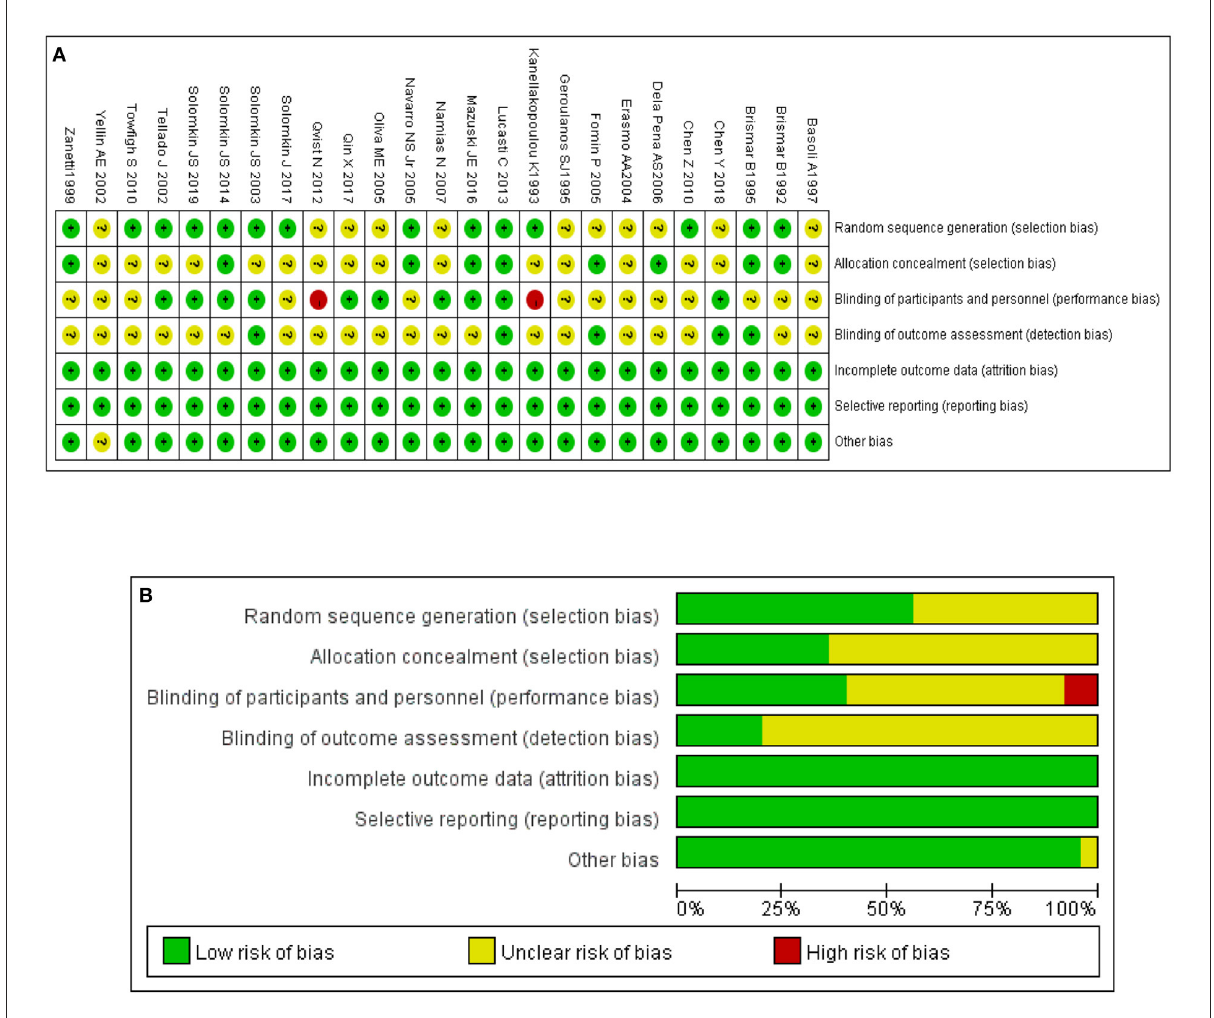
FIGURE2 (A) Risk of bias summary. (B) Bar chart of risk of